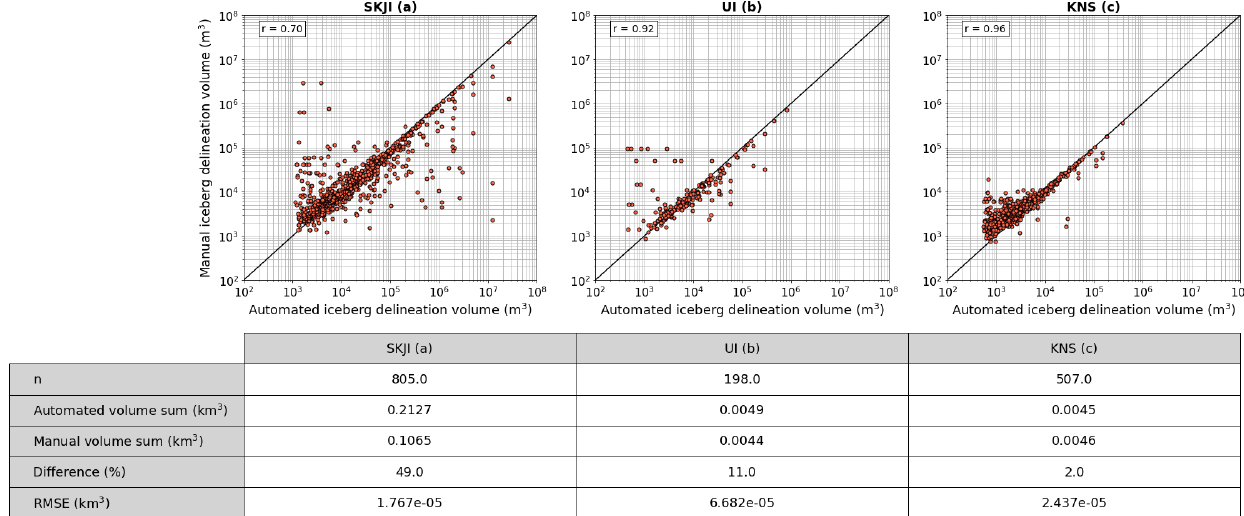
Figure 3. The relationship between the iceberg volume for both the manual and automated delineation methods for each glacier and respective summary statistics. Each point in subplots (a) , (b) and (c) represent a specific iceberg that has been mapped by both the automated and manual delineations. Iceberg volume derivations for both delineation methods were performed in GEE with the associated ArcticDEM as input data, assuming that the icebergs were neutrally buoyant. Pearson’s correlation coefficient is also highlighted (SKJI = 0.70, UI = 0.92, KNS = 0.96).